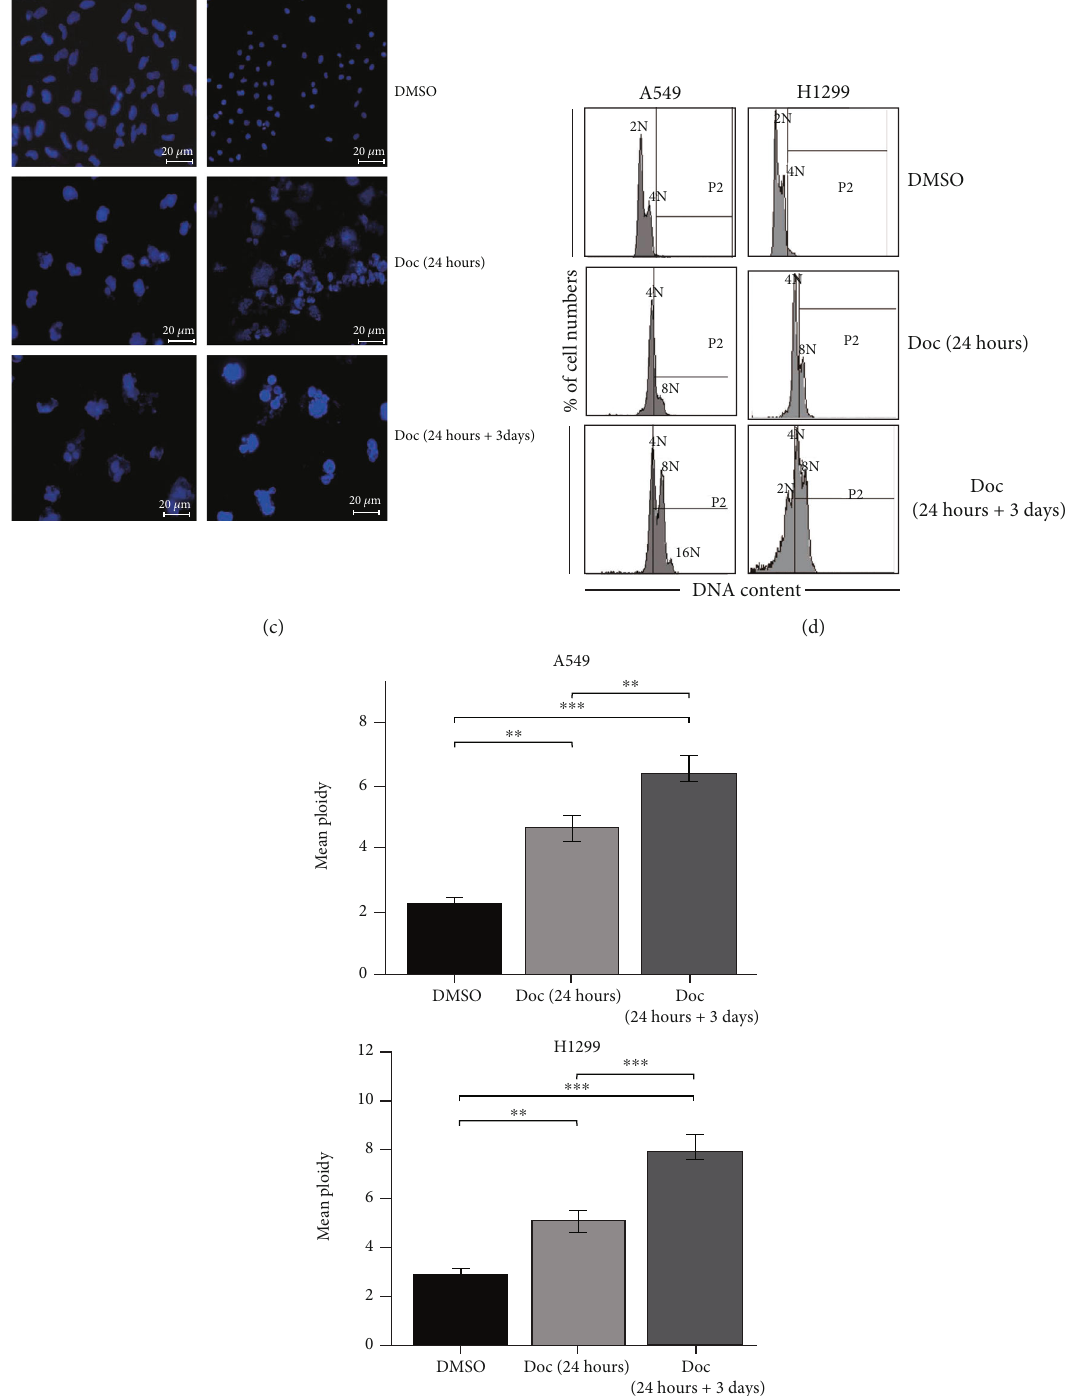
Figure 2: Doc induced formation of the polyploid NSCLC cells. (a) Experimental design. The NSCLC cell lines A549 and H1299 were treated with 1/0.5 μ M Doc for 24 hours to induce mitotic failure and then cultured in a drug-free medium for 3 days. Human umbilical cord-derived MCSs, MSC-CM, MSC-exosomes, and the polyploid A549 or H1299 cells were cultured together for 48 hours or 72 hours in indirect co-culture using the transwell system. (b) Morphologic change in A549 and H1299 cells by conventional light microscopy after treatment with1/0.5 μ M Doc for 24 hours and then cultured in a drug-free medium for 3 days ( × 200). (c) The morphology of the polyploid A549 and H1299 cells were observed by fl uorescence microscopy; blue represented DAPI-labeled nucleus ( × 200). (d, e) DNA content of the polyploid A549 and H1299 cells was analyzed by fl ow